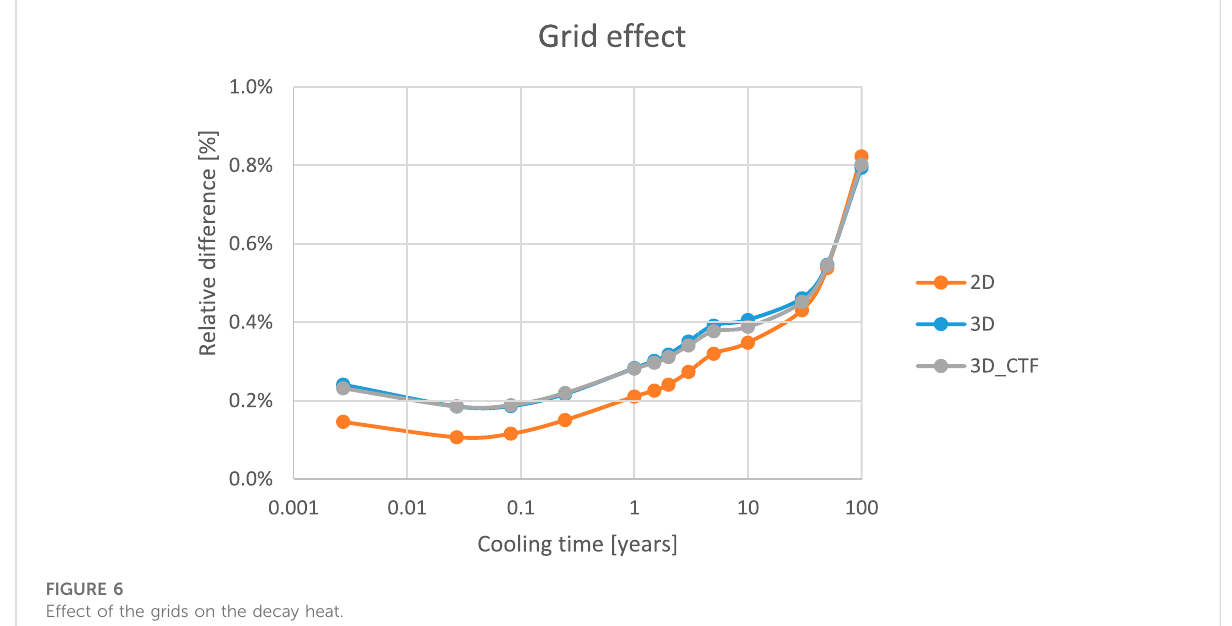
Effect of the grids on the decay heat.